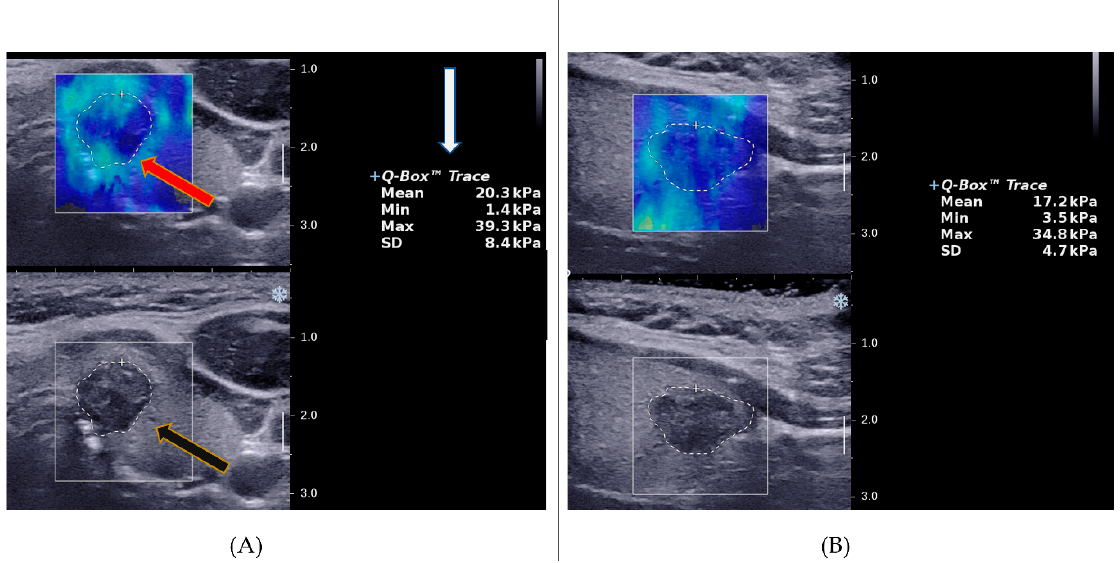
Figure 1. Image representation of the ROI selection for the quantification of stiffness in SWE. ( A ) An illustration of the Q-box placement and the nodule trace outline (red arrow), the output of the quantification of thyroid nodule elasticity in different SWE indices (white arrow) and the grey scale overlay image of the same nodule (black arrow) in the transverse plane. ( B ) The ROI trace representation and SWE quantification of the same nodule in the longitudinal plane. The scale on the right side of either image, represents the tissue depth from the point of contact of the transducer on the neck area, whereby 1.0 = 10 mm.